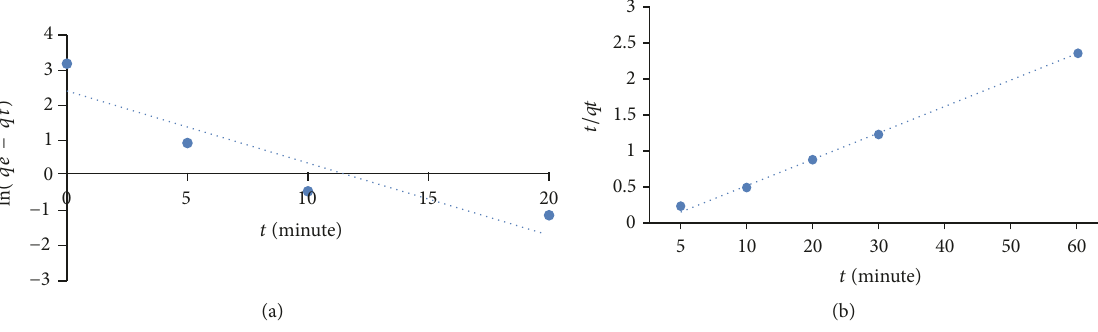
Figure 12: The adsorption kinetics of P(DEAMSt0.30-co-MMA): (a) first-order and (b)